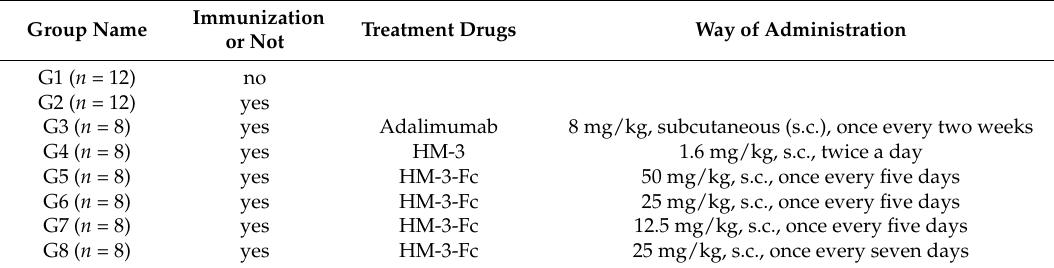
Table 1. Strategy of collagen-induced arthritis (CIA) model mice